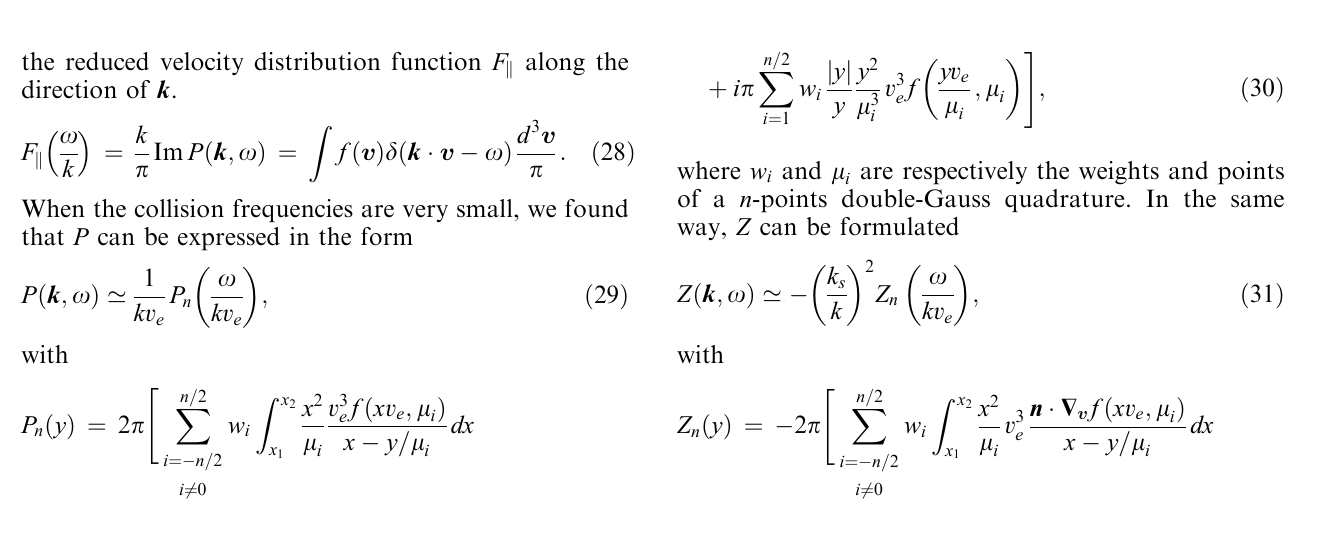
Fig. 5. On the left, the real and imaginary parts of the P n function given by Eq. (35) for complex argument such that the imaginary part (cid:103) (cid:136) 0 : 1. On the right, their relative error with the real and imaginary parts of Z (cid:133) z = the plasma dispersion function (Fried and Conte, 1961). The normalized Doppler shift of the Maxwellian distribution is x d (cid:136) 0